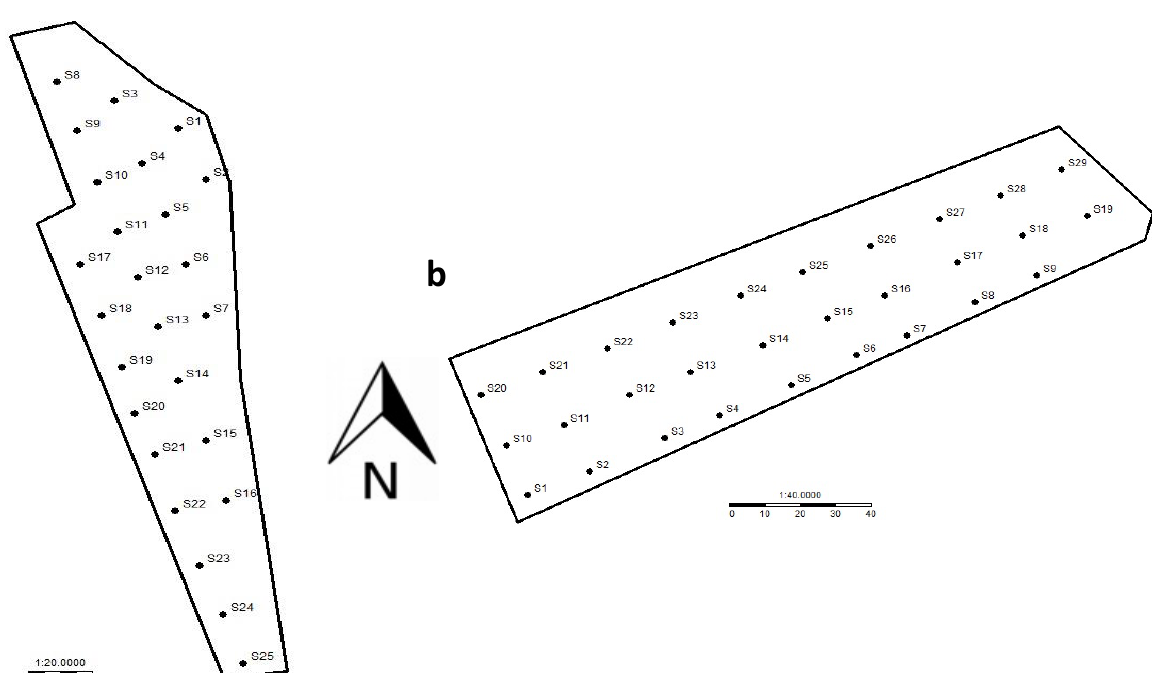
Table 1. Main characteristics of the table grapes under study.